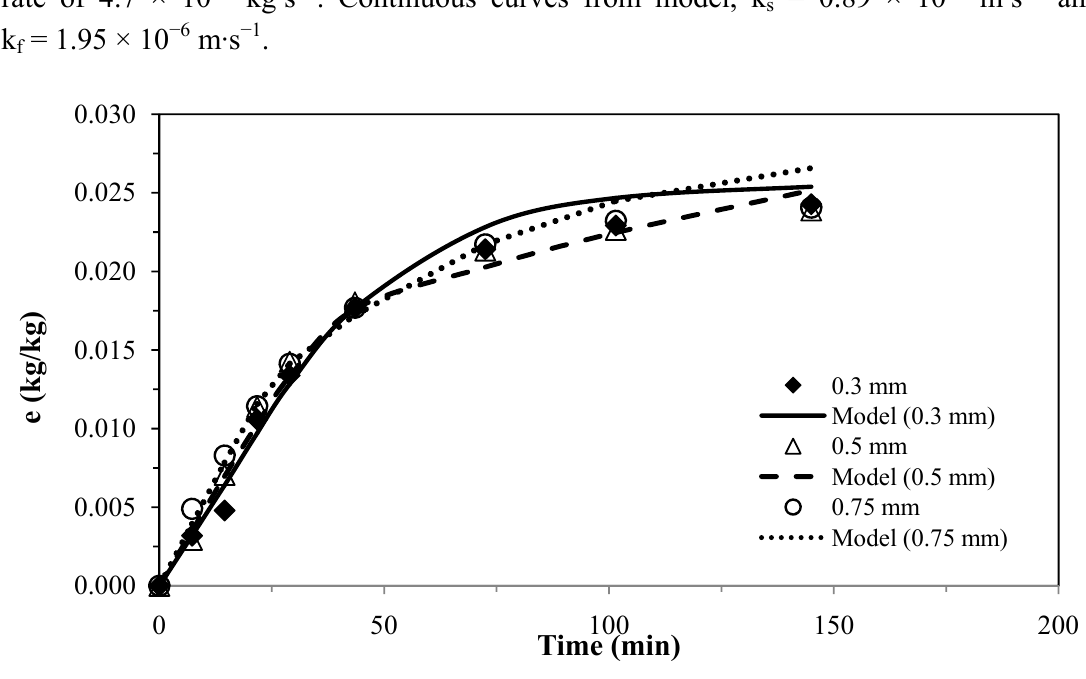
flow 2 = 0.89 × 10 –8 m·s − 1 and s